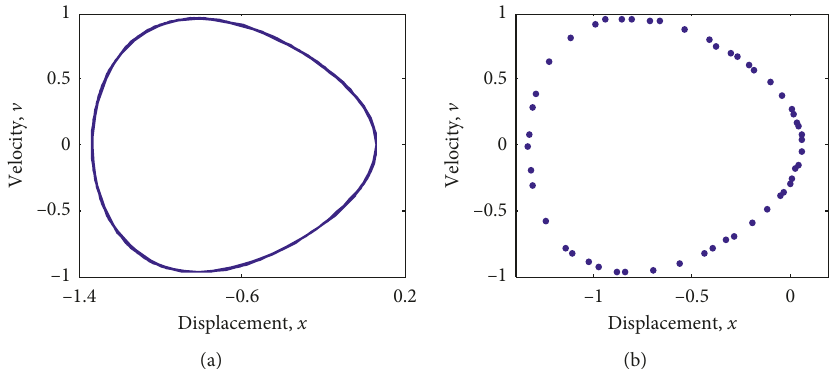
Figure 12: Dynamic response of the system at ω � 1.29. (a) Phase diagram. (b) Poincar´e map.